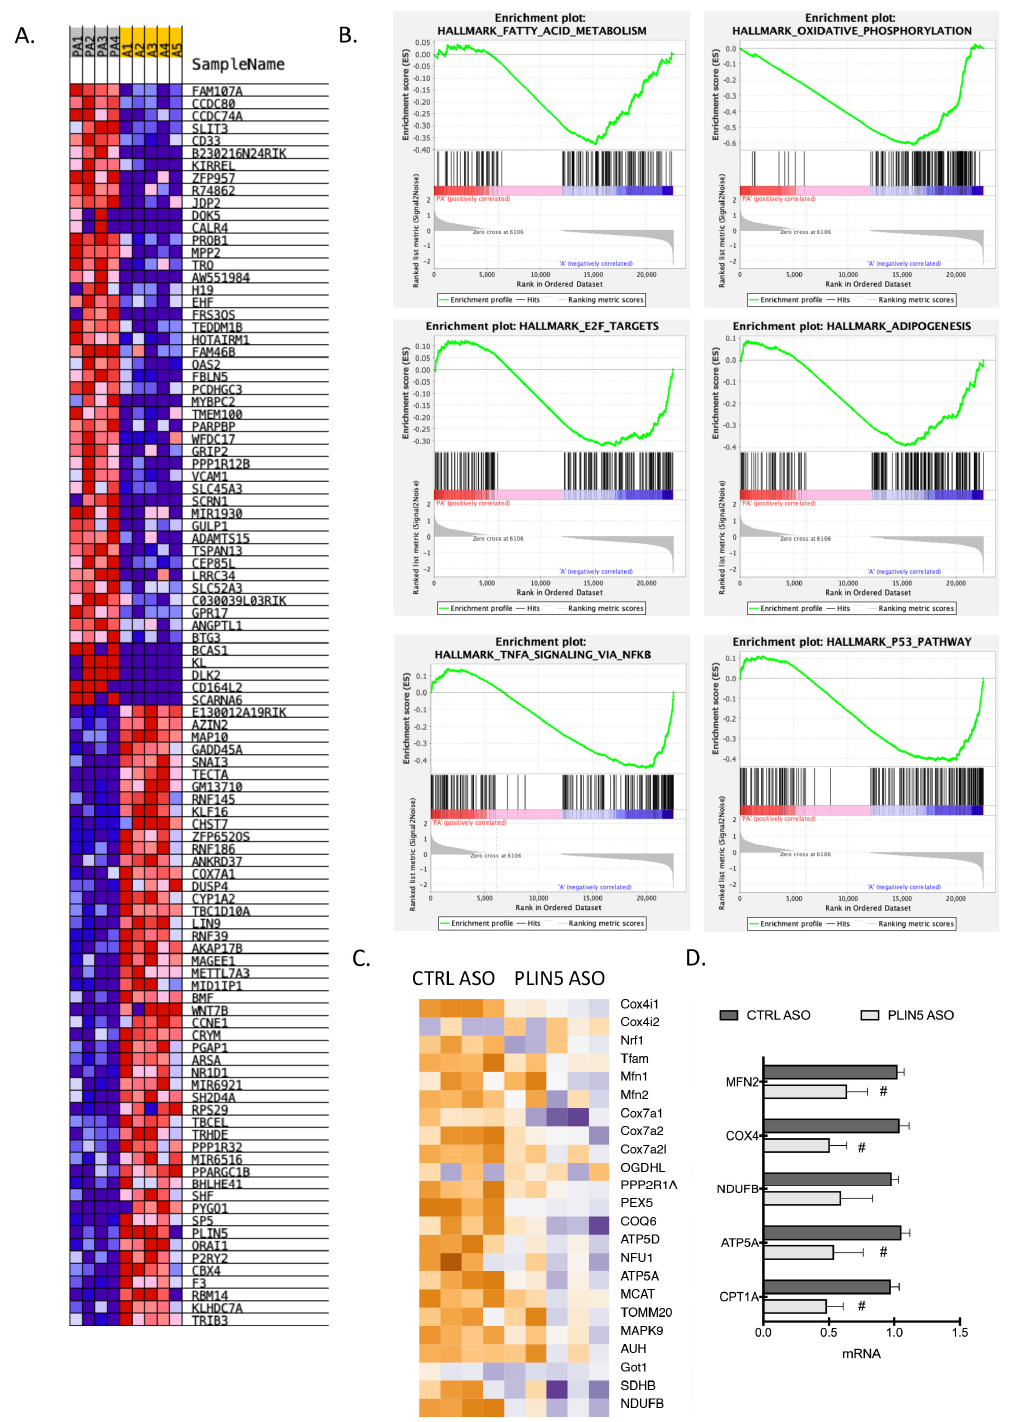
Figure 2. Ablation of PLIN5 inhibits fatty acid lipogenesis via mitochondrial dysfunction. ( A ) Heat map of differentially expressed genes in hepatocytes treated with CRTL ASO or PLIN5 ASO. ( B ) GSEA analysis showed that pathways including fatty acid metabolism, oxidative phosphorylation, E2F targets, adipogenesis, TNF α signaling via NF- κ B and p53 pathway were highly enriched in PLIN5 ASO hep- atocytes. ( C ) Heat map of mitochondrial related genes in response to PLIN5 ASO in primary mouse hepatocytes. The color scale shows the fold change of gene expression in a purple-white-orange (from low to high expressions) scheme. ( D ) mRNA abundance of MFN2, COX4, NDUFB, ATP5A and CPT1A in hepatocytes treated with PLIN5 ASO. # p < 0.05 vs. CTRL